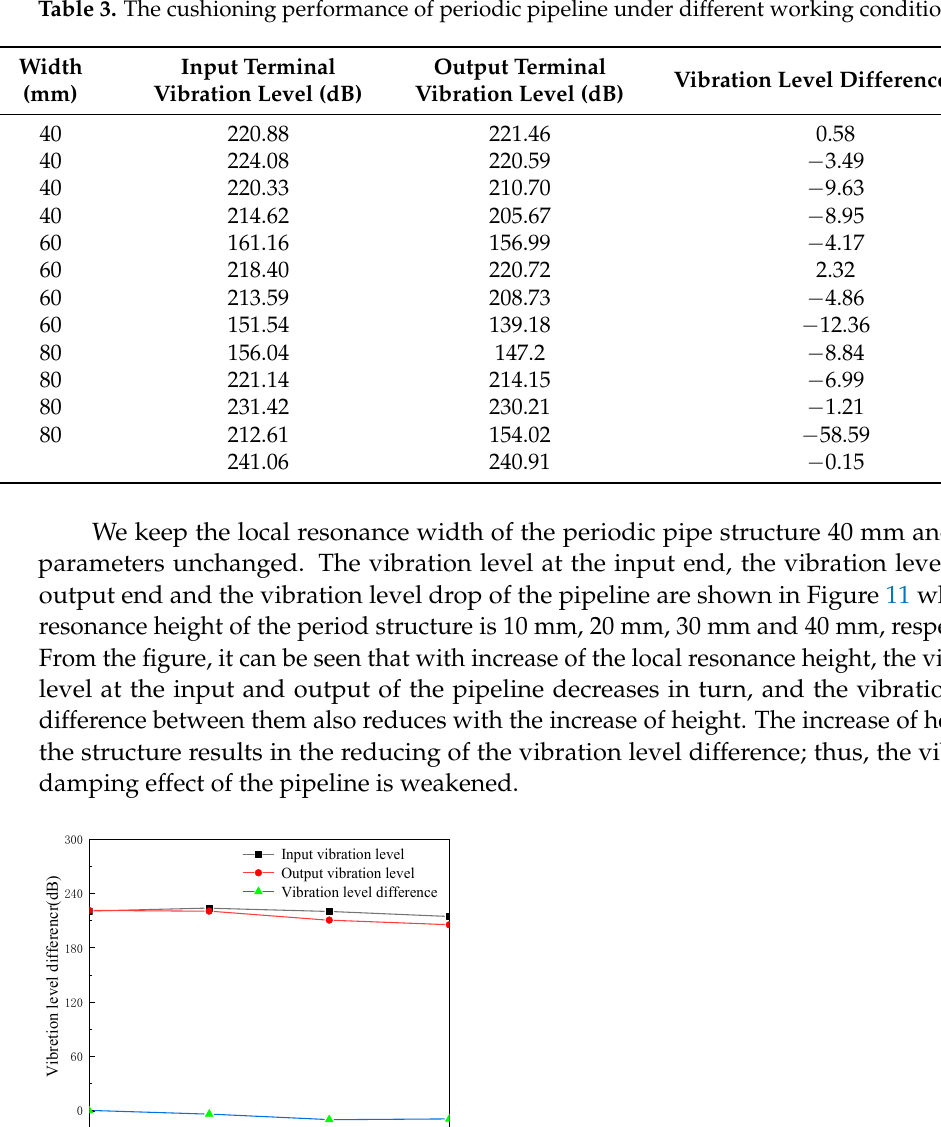
Figure 8. Finite period pipe structure.